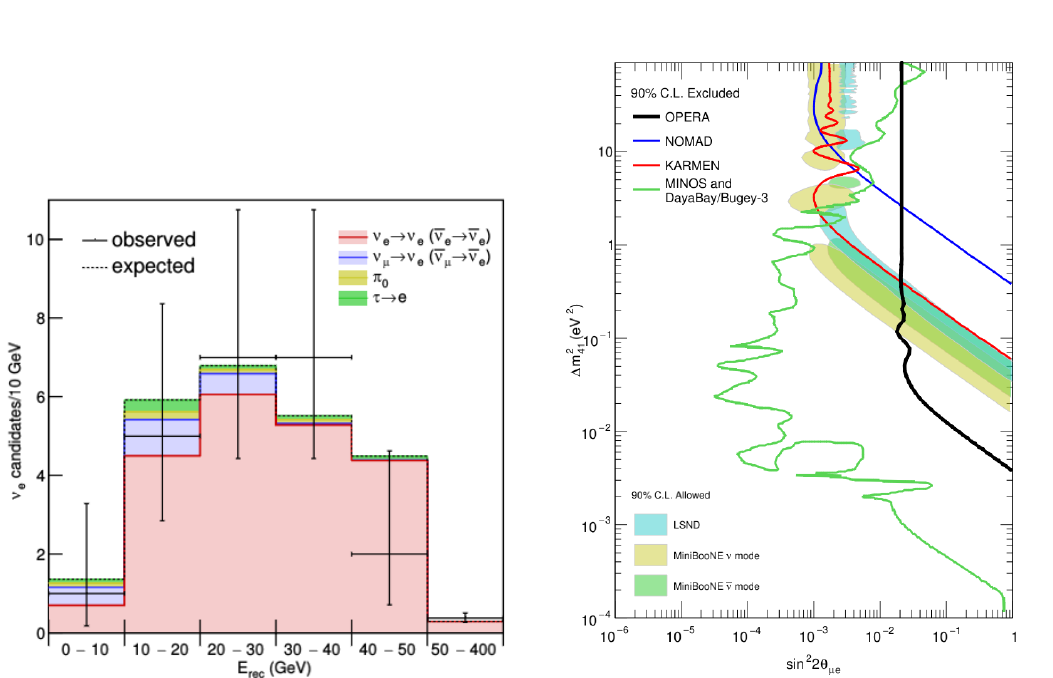
Figure 4. Left plot: reconstructed energy distribution for the observed ν e Charged Current (CC) events. The MonteCarlo expectations for signal and background are also shown. Right plot: 90% excluded ν e oscillations. Exclusion regions obtained region for the 3 + 1 model by OPERA results on ν µ → by NOMAD, KARMEN as well as the MINOS and DayaBay/Bugey-3 joint analysis are also shown, together with the allowed regions obtained by LSND and